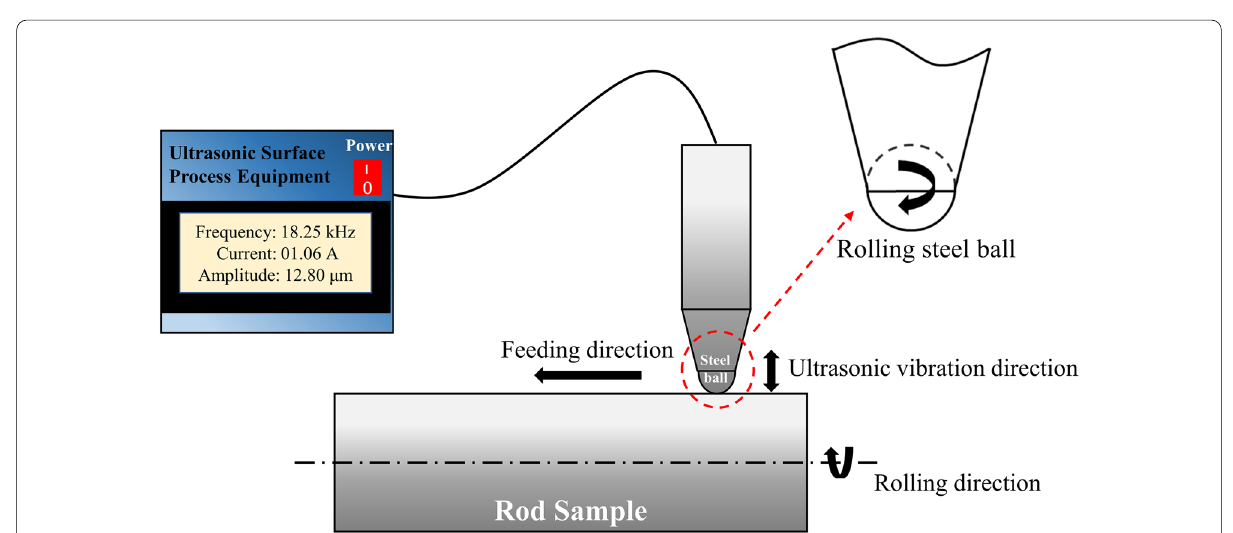
Figure 2 Schematic image of ultrasound-aided deep rolling (UADR)